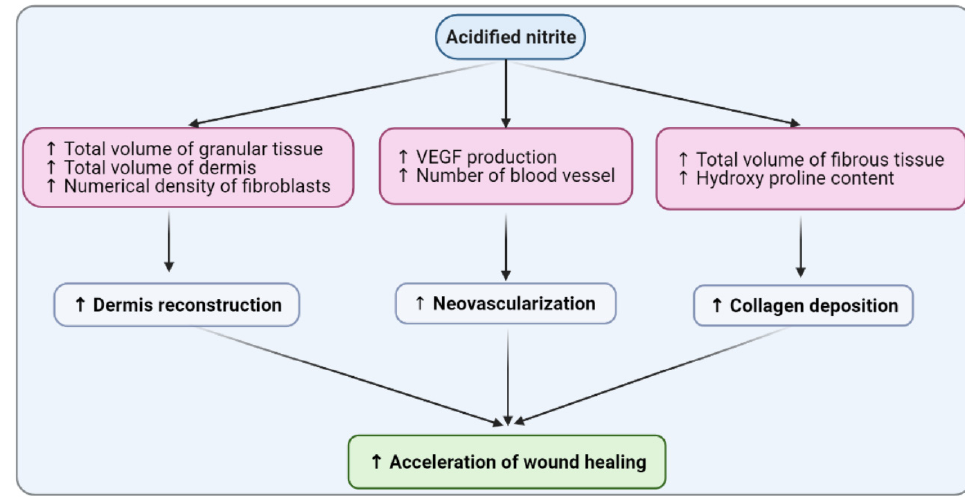
Figure 9. Mechanisms by which acidified nitrite improves diabetic wound healing. Supplementary Materials: The following are available online at: Figure S1: Wound induction.